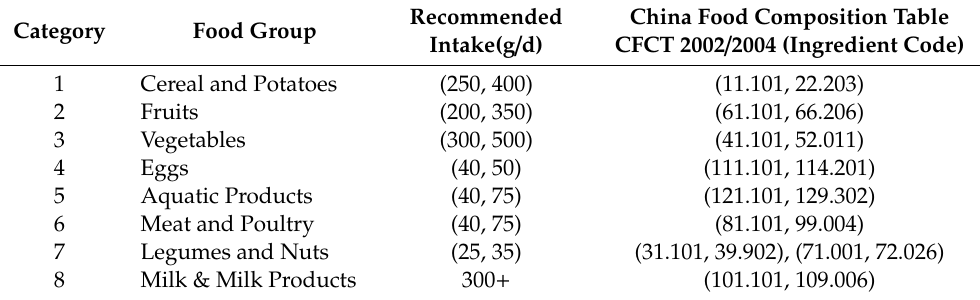
Table 1. The range of daily recommended intakes in Chinese food pagoda (CFP) 2016 and the corresponding ingredient code in China Food Composition Table (CFCT) 2002 /